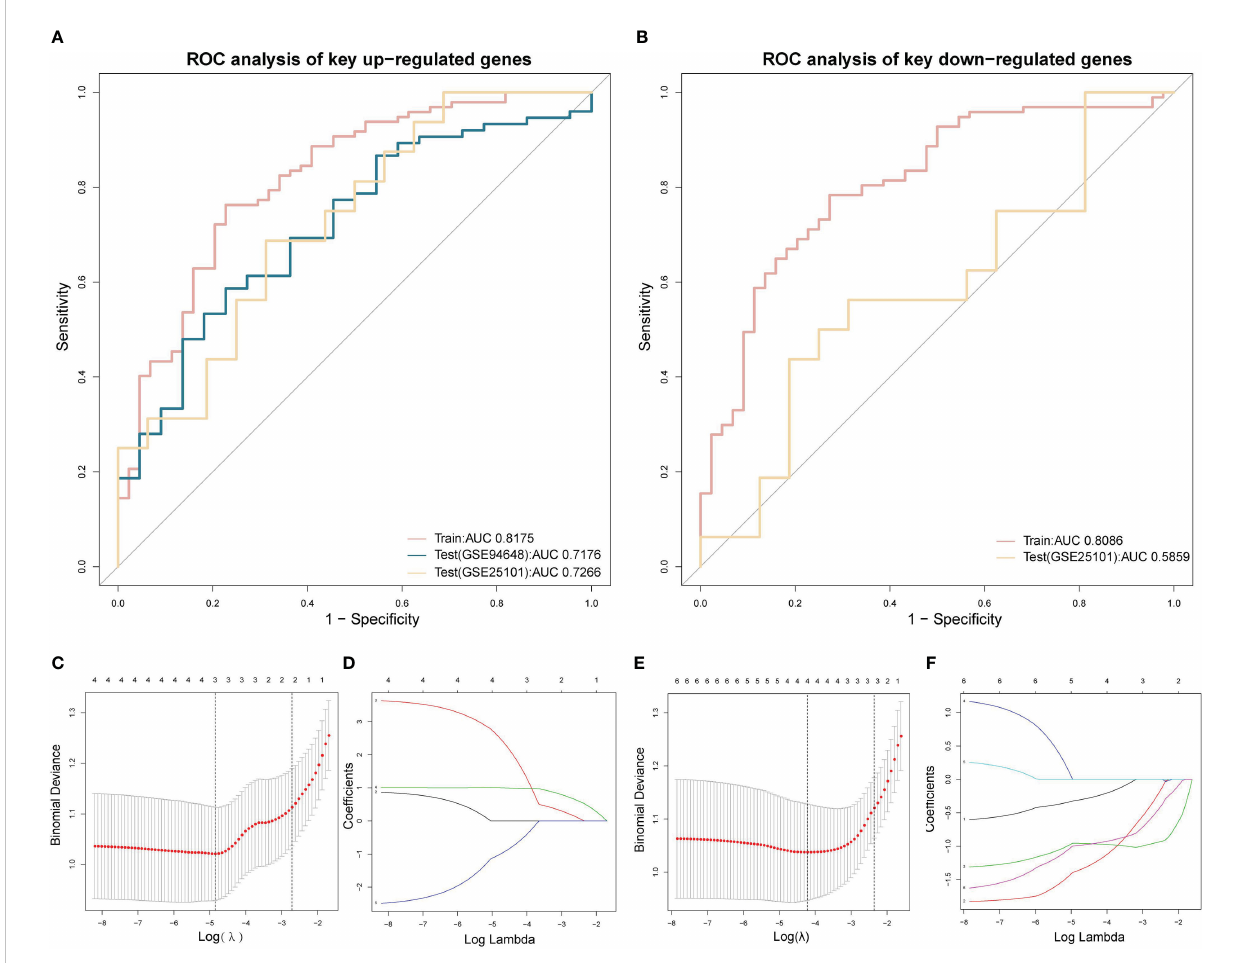
FIGURE 9 LASSO regression and ROC analysis (A) ROC of the LASSO regression model of up-regulated key coDEGs in train datasets (GSE73754 and GSE86434) and test datasets (GSE25101 and GSE94648). (B) ROC of the LASSO regression model of down-regulated key coDEGs in train datasets (GSE73754 and GSE86434) and test dataset (GSE25101). (C) Binomial deviance of LASSO regression model of up-regulated key coDEGs. (D) Coef fi cients of LASSO regression model of up-regulated key coDEGs. (E) Binomial deviance of LASSO regression model of down-regulated